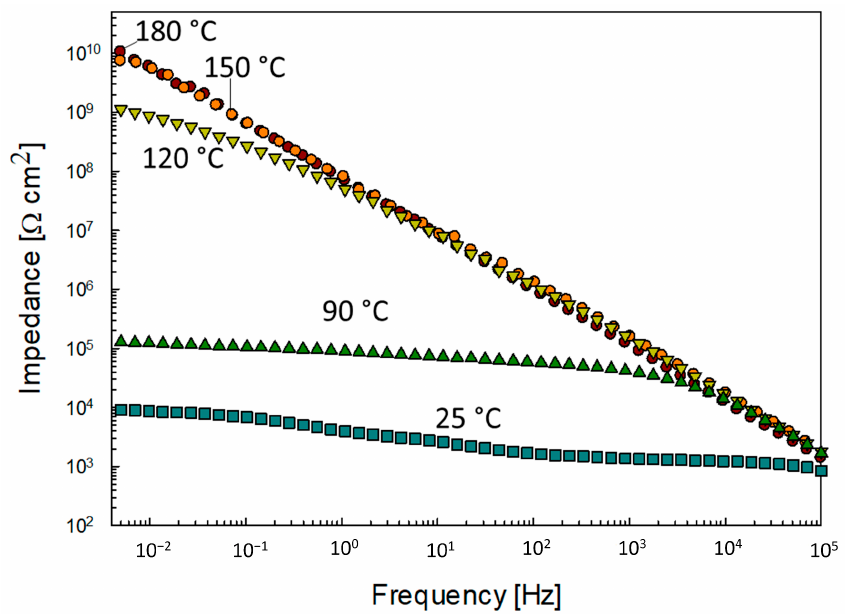
Figure 5. Bode plots of impedance magnitude of PBMA-siloxane coatings, cured at different tem- peratures and measured after immersion in 3.5 wt.% NaCl at 13 weeks. Symbols correspond to the experimental data. The withdrawal rate was 2.33 mm/s.